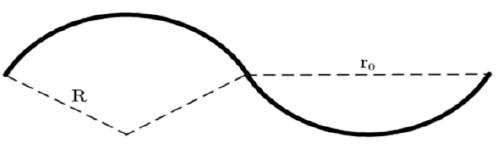
Figure 11. Schematic diagram of a bend fiber. Here, R and r 0 are the radius and wavelength of the sinusoidal curve.